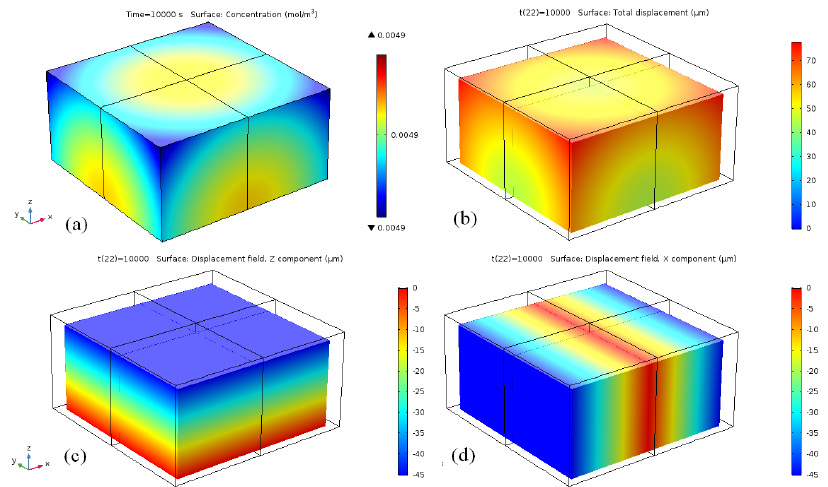
Figure 16. ( a ) Concentration of the backbone debinder after sintering; ( b ) total displacement; ( c ) direction z displacement; ( d ) x displacement. The parameters are β = 10 − 3 m 3 /kg, initial concentration 10 3 mol/m 3 , diffusion coefficient D = 4 × 10 − 6 m 2 /s, brown part density was taken as 3000 kg/m 3 , Young’s modulus 10 GPa, Poisson’s ratio